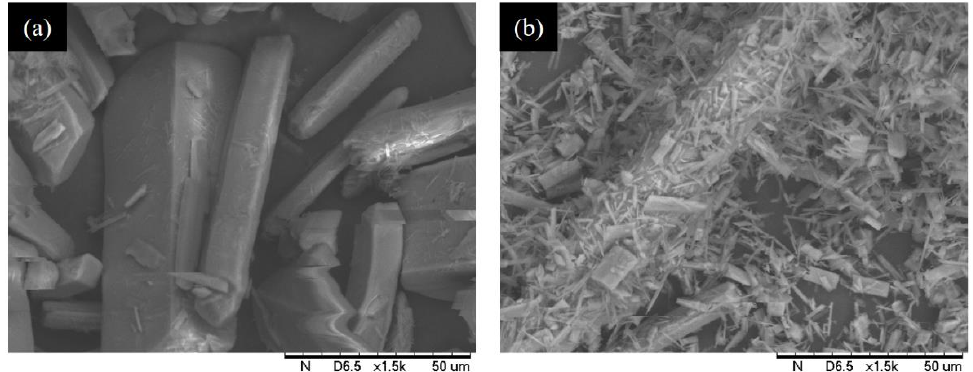
Figure 6. Scanning electron micrographs of calcium L -malate crystals. ( a ) Calcium L -malate precipitated at 55 °C reaction. ( b ) Calcium L -malate precipitated at 65 °C reaction.